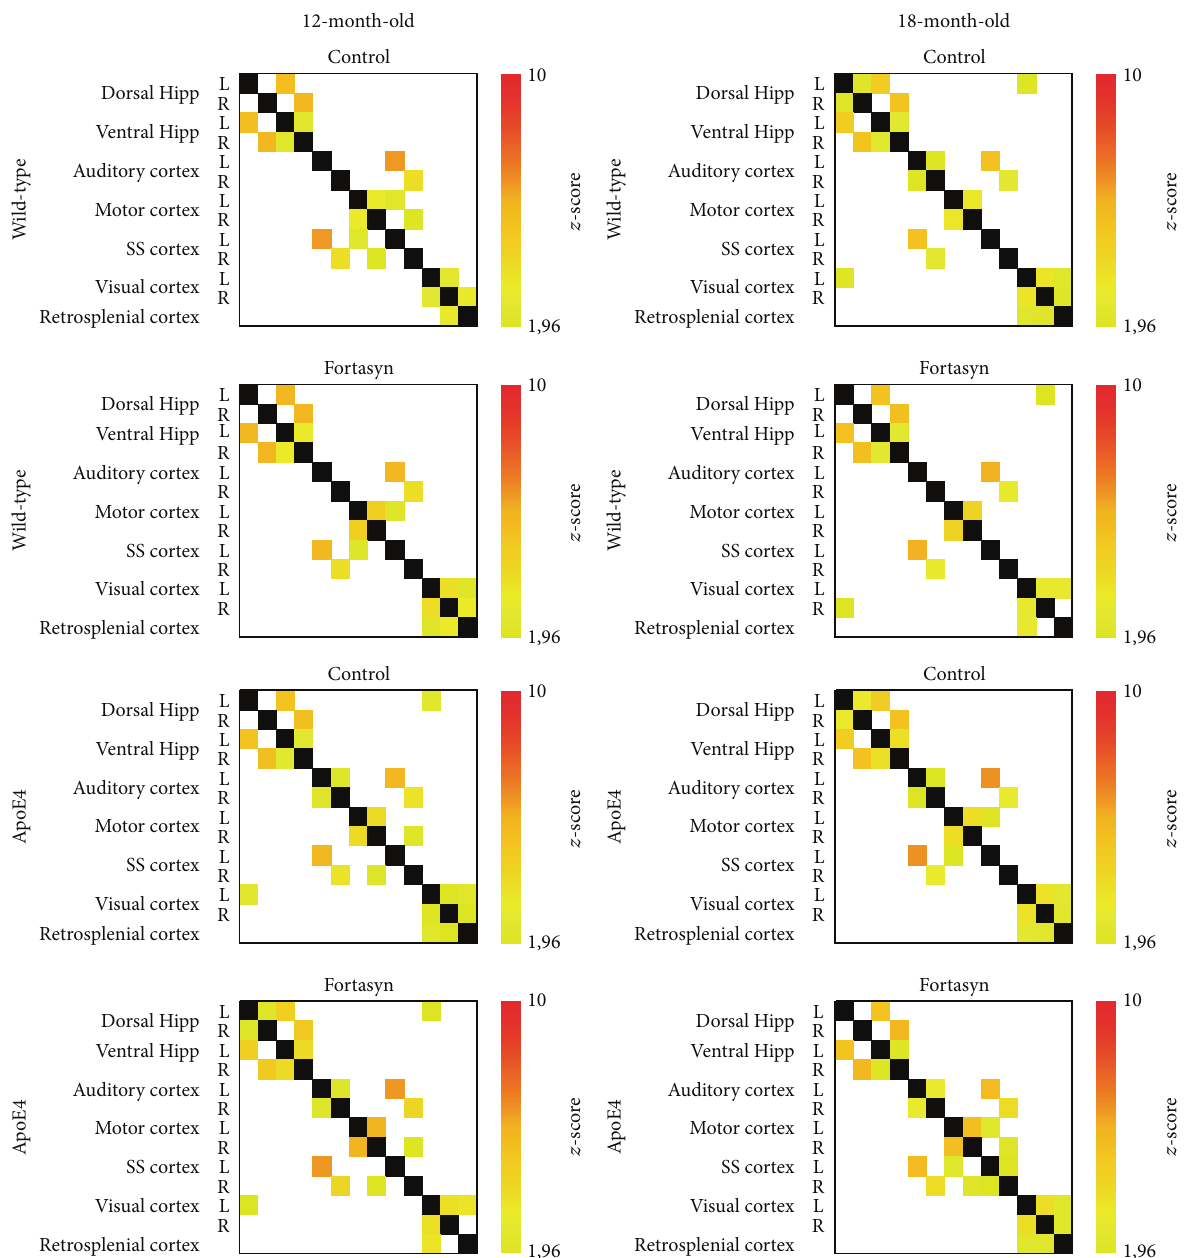
Figure 6: Resting-state functional connectivity (FC) based on partial correlation analyses of 15 regions of interest (ROIs) in the mouse brain. Total correlation matrices of wild-type and apoE4 at 12 and 18 months of age, both on Fortasyn and control diets. At 12 months of age, apoE4 mice showed a reduced FC pattern between left dorsal and ventral hippocampus ( 𝑝 = 0.040 ). Additionally, animals on Fortasyn compared to control diet showed an increased partial correlation in the interhemispheric connection between left and right ventral hippocampus ( 𝑝 = 0.012 ). At 18 months of age, ApoE4 mice on both diets had a reduced FC between the right auditory cortex and the right motor cortex ( 𝑝 < 0.001 ). The Fortasyn diet caused contrasting effects: a higher FC was found between left-to-right motor cortices ( 𝑝 = 0.013 ), but a slight FC reduction was revealed between left and right dorsal hippocampus ( 𝑝 = 0.045 ). Fortasyn diet increased partial correlation in apoE4 mice compared to their wild-type littermates between left and right auditory cortex ( 𝑝 = 0.015 ) and between right auditory cortex and right somatosensory cortex ( 𝑝 = 0.015 ). In wild-type mice FC between left somatosensory cortex and left auditory cortex ( 𝑝 = 0.041 ) was higher in Fortasyn fed animals compared to control fed